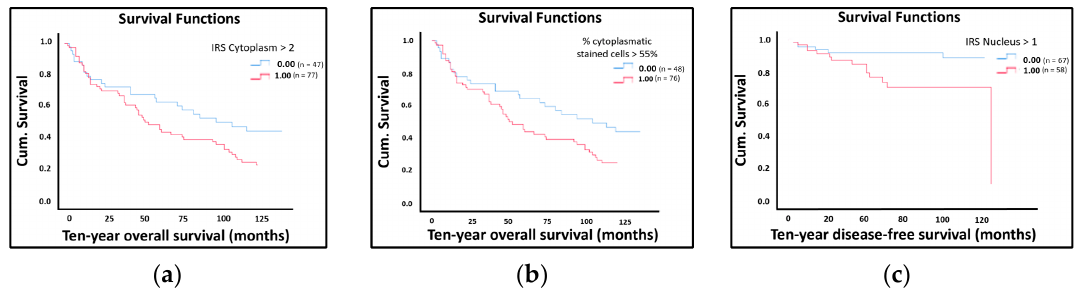
Figure 3. The Kaplan–Meier estimates show that high LDOC1 expression leads to decreased ten-year overall survival / disease-free survival. The red curves represent the event specified in the top-right corner of each graph, while the blue curves represent the opposing event: ( a ) Kaplan–Meier survival univariate analysis for the status cytoplasmatic IRS > 2. Positive expression of LDOC1 in the cytoplasm significantly reduced ten-year overall survival ( p = 0.049); ( b ) Kaplan–Meier survival univariate analysis for the status cytoplasmatic stained cells > 55%. Expression of LDOC1 in 55% of the cytoplasm positively stained cells were significantly related to a worse ten-year overall survival ( p = 0.046); ( c ) Kaplan–Meier survival univariate analysis for the status nuclear IRS > 1. Positive nuclear staining of LDOC1 showed a significant negative influence on ten-year disease-free survival ( p = 0.031).